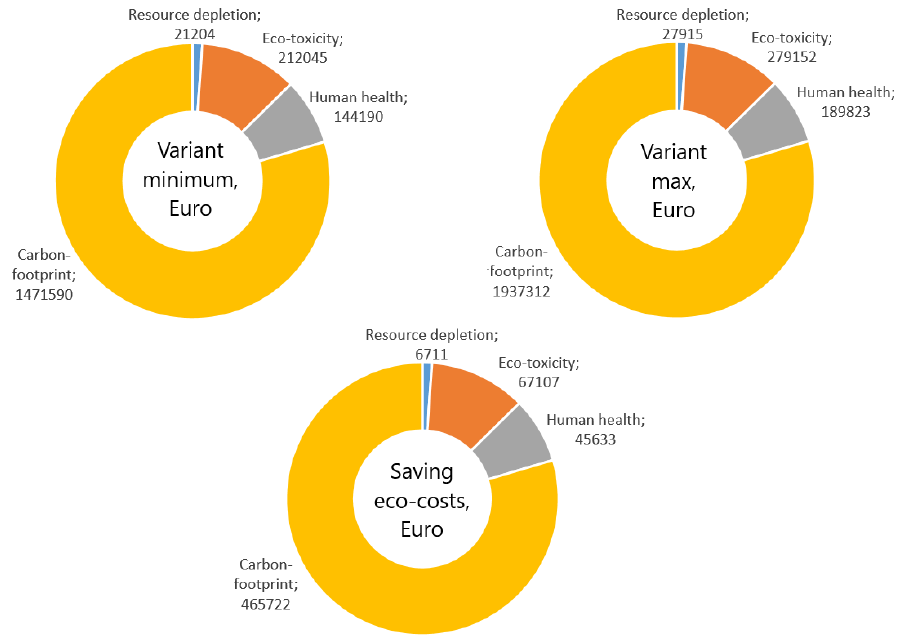
Figure 15. Influence of the technology of wire manufacturing on the generation of costs (in Euro) caused by energy consumption in relation to the production of 100,000 tons of steel wire.